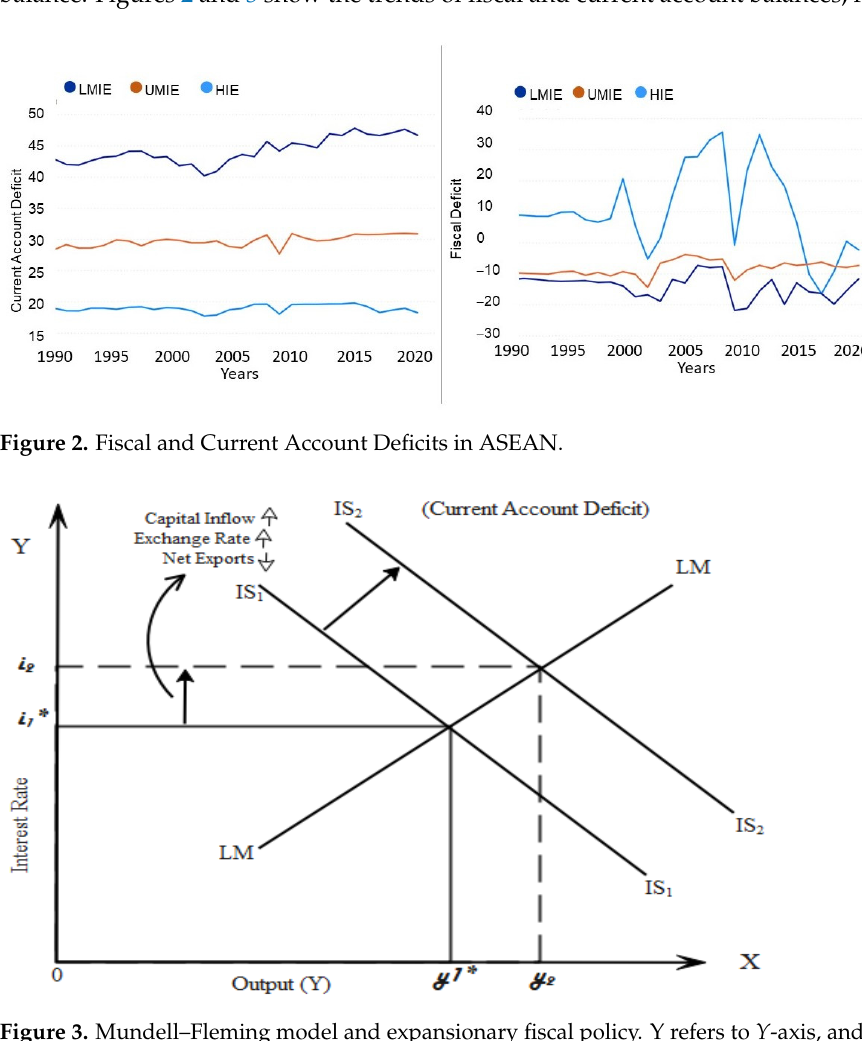
Figure 3. Mundell–Fleming model and expansionary fiscal policy. Y refers to Y -axis, and Y 1 , Y 2 refer to output. The * represents the initial values.